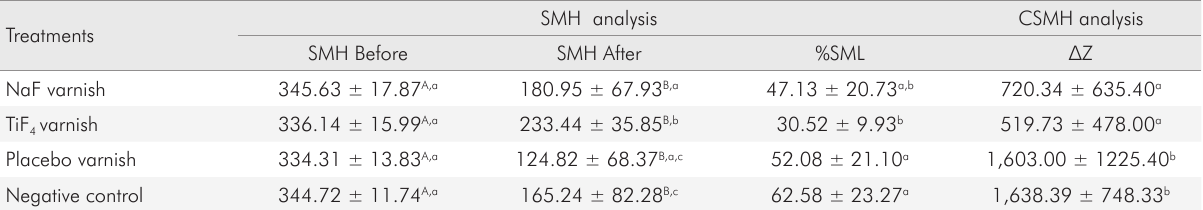
Table 1. Surface microhardness analysis before and after the experiments, percentage of enamel surface microhardness loss and cross-sectional microhardness analysis according to the treatments – 14 days after the treatments (means ± standard deviation)